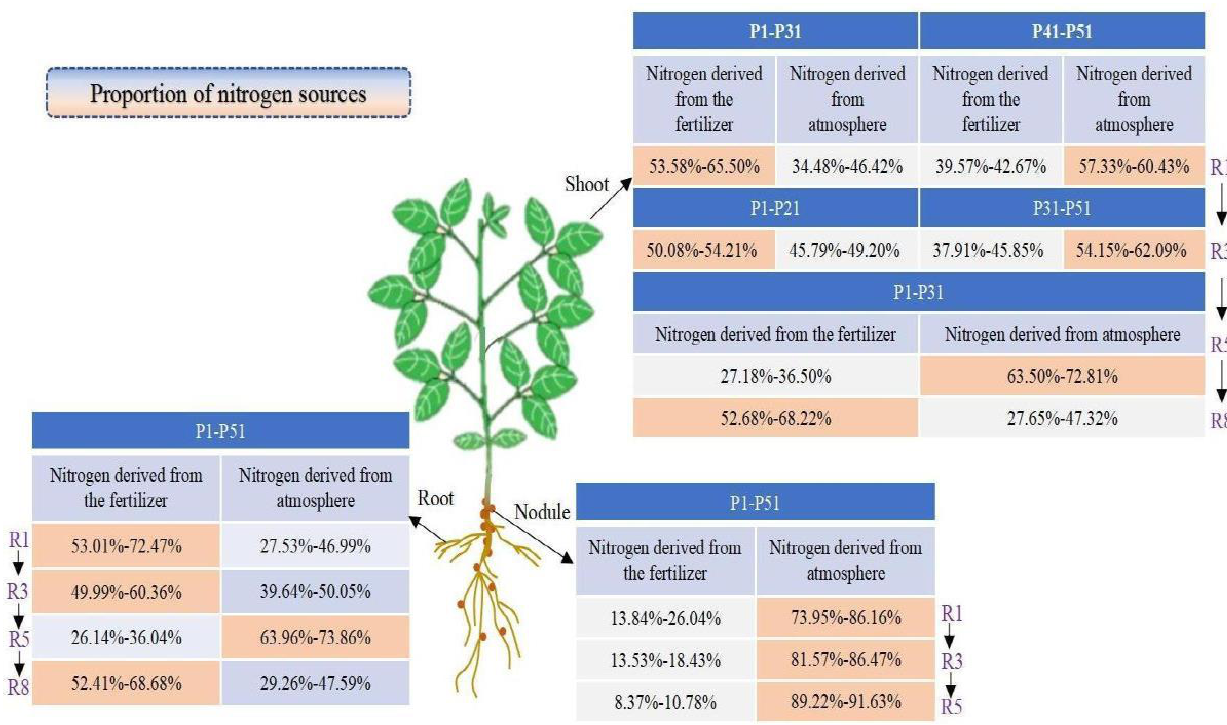
Figure 2. The proportion of nitrogen sources in soybean organs in different growth stages under different phosphorus supply levels.